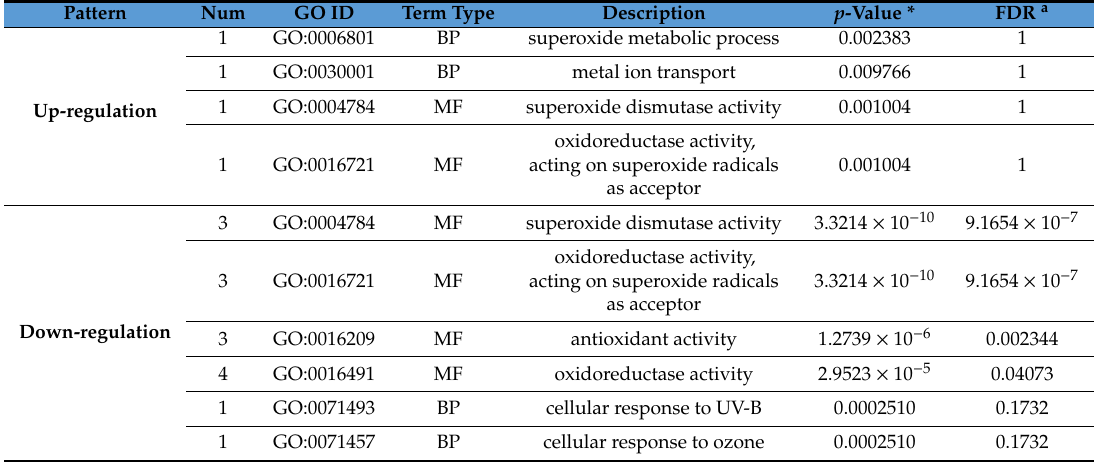
Figure 2. Directed acyclic hierarchical graph (DAG) of gene ontology (GO) terms regulated by trypsin. The figure illustrates a subset of the molecular function DAG for superoxide metabolic process (GO:0006801) and metal ion transport (GO:0030001). The ancestors of GO:0006801 or GO:0030001 are highlighted back to the root of the biological process (GO:0008150) ontology via arrows. Table 1. Top 10 GO enrichment terms related to HuSODs ( p < 0.01) by trypsin.